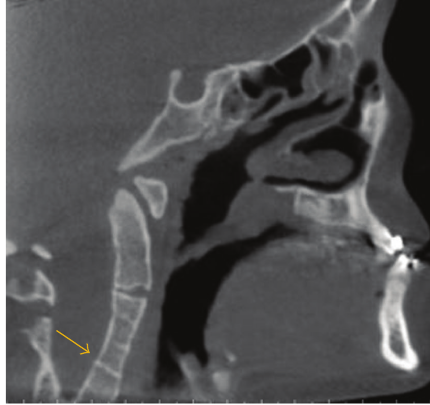
Figure 8: A sagittal view demonstrates fusion of the C3-C4.